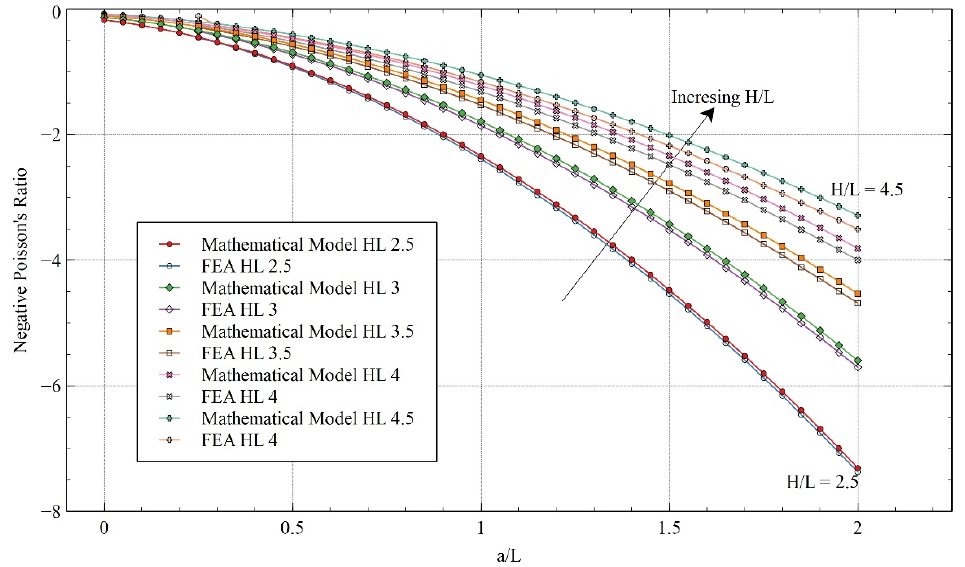
Figure 12. Poisson’s ratio obtained from the FEA and mathematical model for varying H/L for x- direction loading.